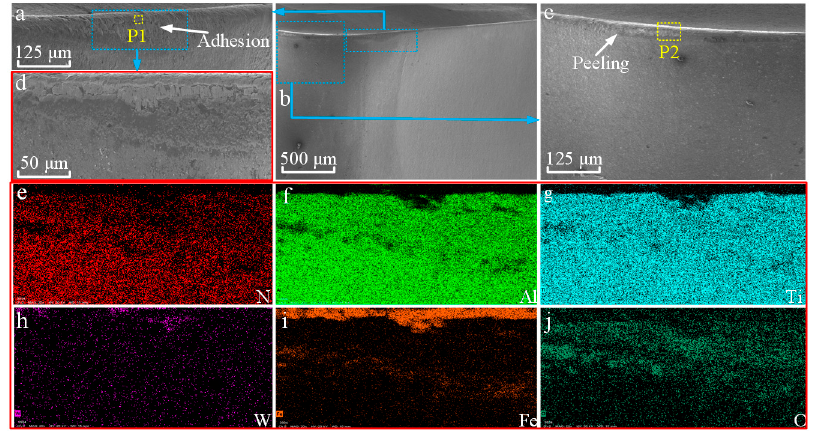
Figure 18. ( a – d ) The flank face wear of Tool B after 82 min of cutting. ( e – j ) Distribution of elements. Similarly, the severe wear area on the flank face was selected as the scanning point, and the analysis was conducted by the energy spectrum. As shown in Figures 19 and 20, the O contents of Point P1 and P2 of Tool A are 73.12% and 65.971%, respectively, while the corresponding points of Tool B are only 39.955% and 31.776%, respectively, indicating that the oxidation wear of Tool A was more serious in this area, while the Fe contents of Tools A and B were relatively close.